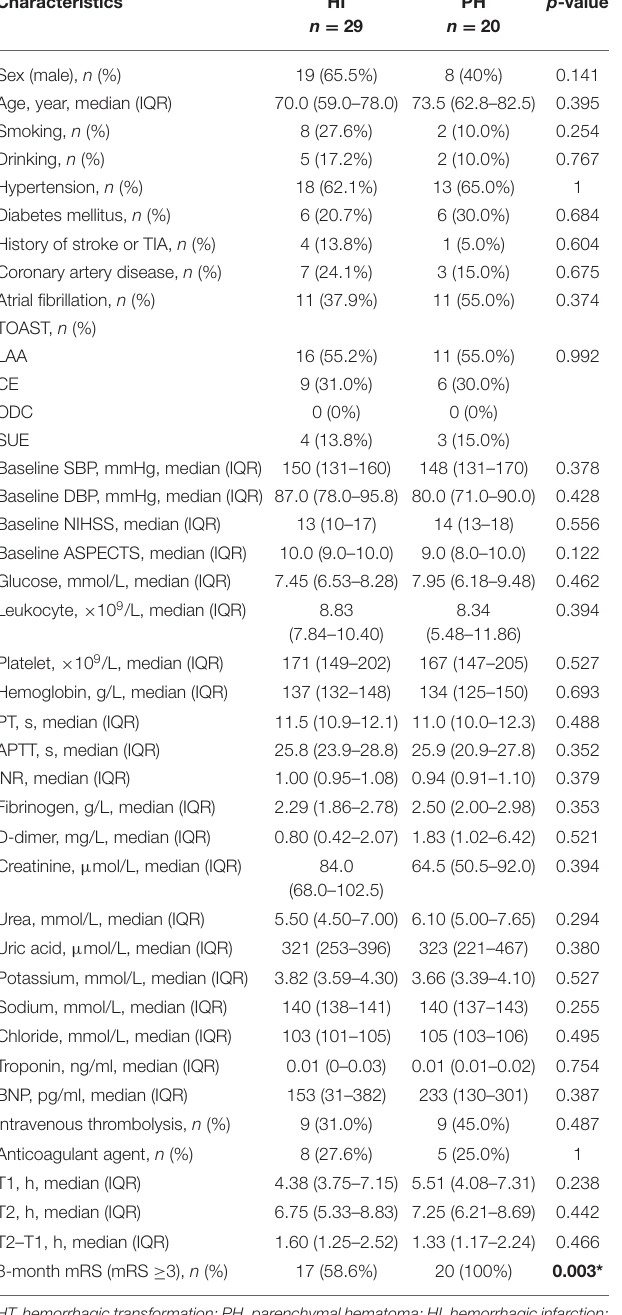
TABLE 3 | Univariate and multivariate logistic regression analyses of risk factors for HT in AIS patients with MT. Univariate